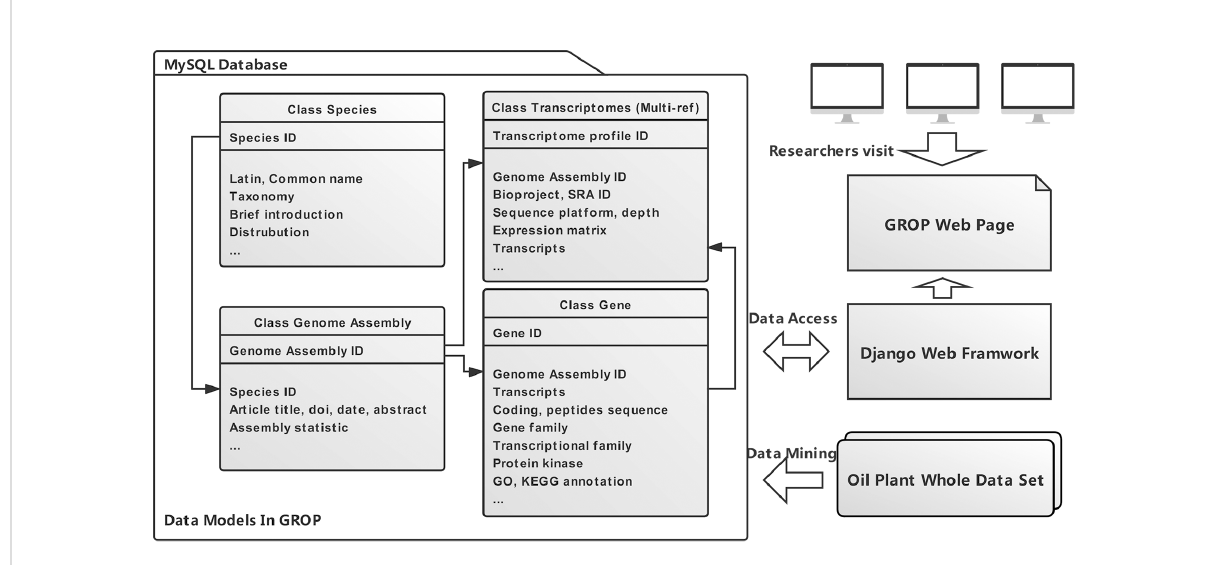
FIGURE 1 An overview of the GROP complete architecture. In general, four data models (species, genome assembly, transcriptome pro fi le, and gene) were built through data mining from an oil plant whole dataset. Researchers are able to visit GROP via the Django web